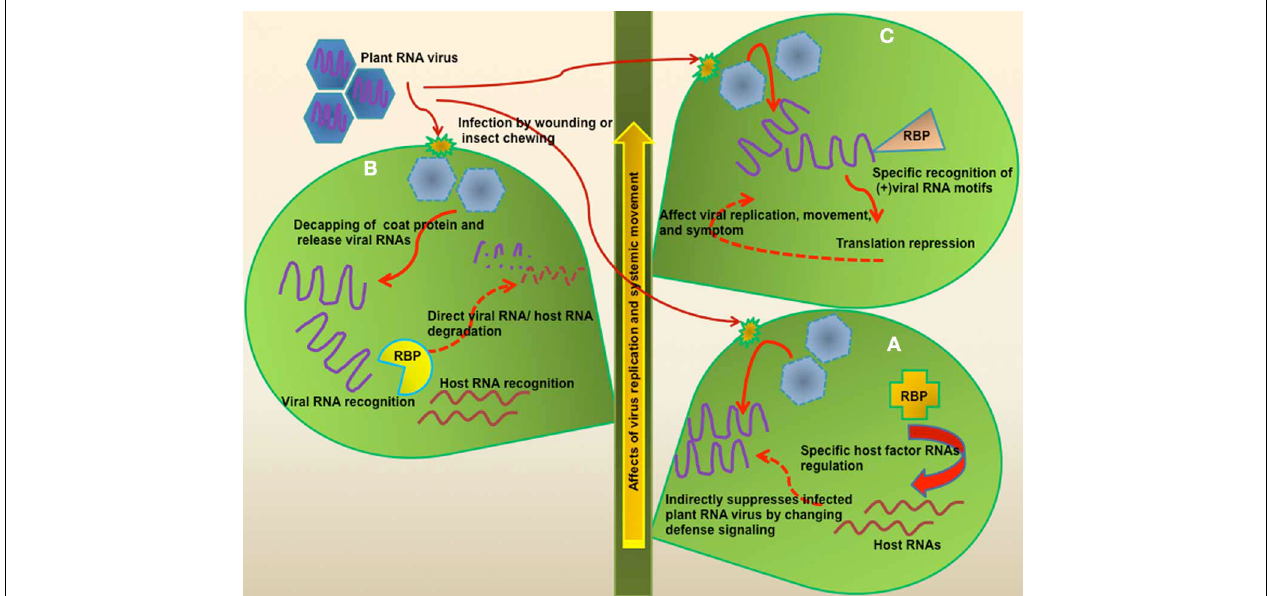
FIGURE 1 | Modes of defense function of RBPs against plant RNA virus infection. Most plant RNA viruses enter the host cell by wounding or insect damage. In the host cell, viral RNAs are released from a coat protein and then localize to the membrane-like structures in order to protect naked viral RNA. How plants recognize plant virus infection is still unknown. Plants positively set up viral RNA-targeted defense system using host RBPs. (A) Some RBPs regulate plant defense signaling pathway genes at posttranscriptional levels and these can control a variety of pathogens in addition to viruses. The direct target RNAs of most RBPs were still not identified. (B) PR10 family proteins have RNase activity, as